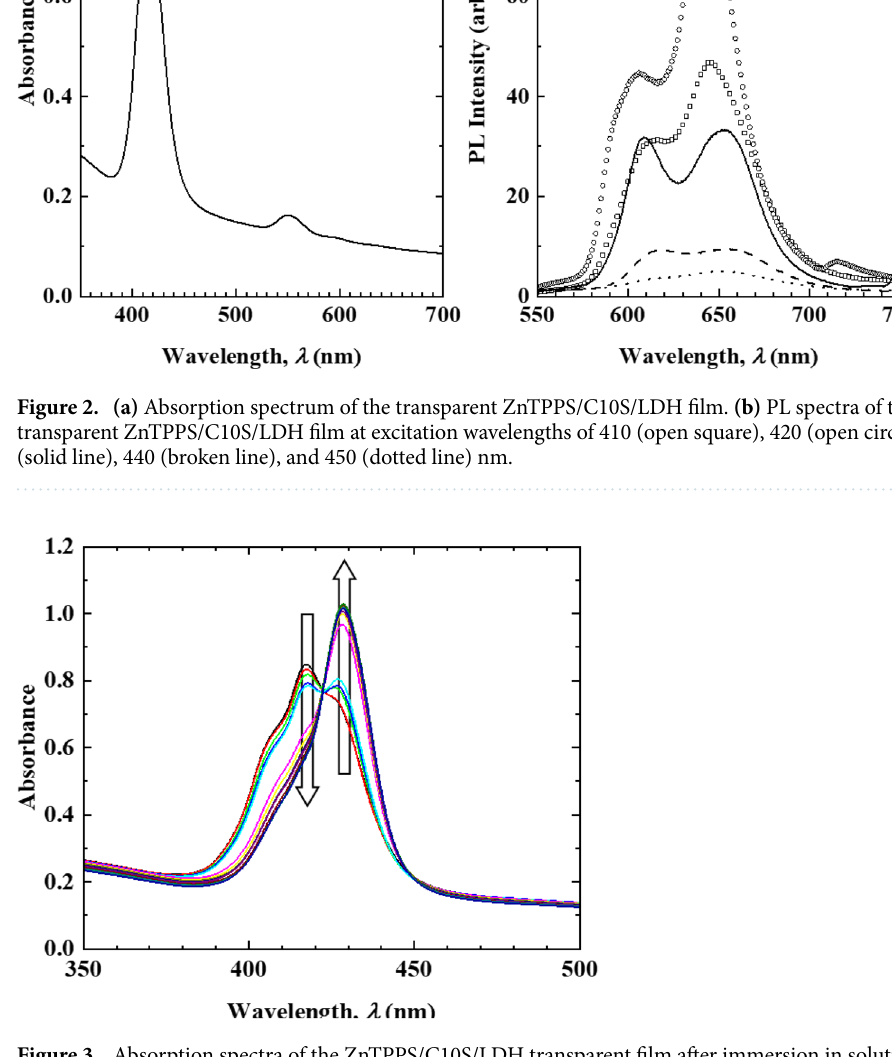
Figure 3. Absorption spectra of the ZnTPPS/C10S/LDH transparent film after immersion in solutions of various [Pyridine] ([Pyridine] = 12.3 µmol/L to 0.123